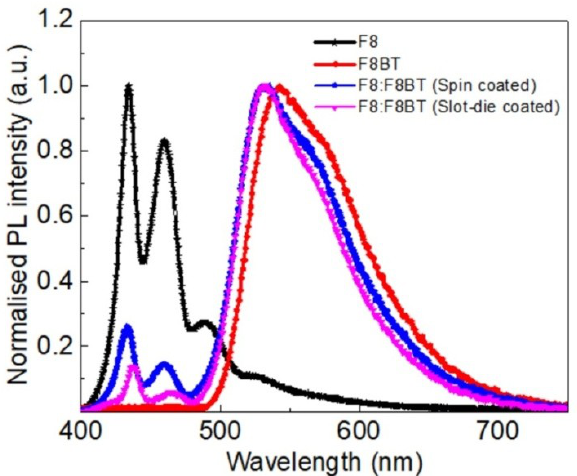
Figure 10. Normalized photoluminescence emission spectra of F8, F8BT films, and the film of their blend.